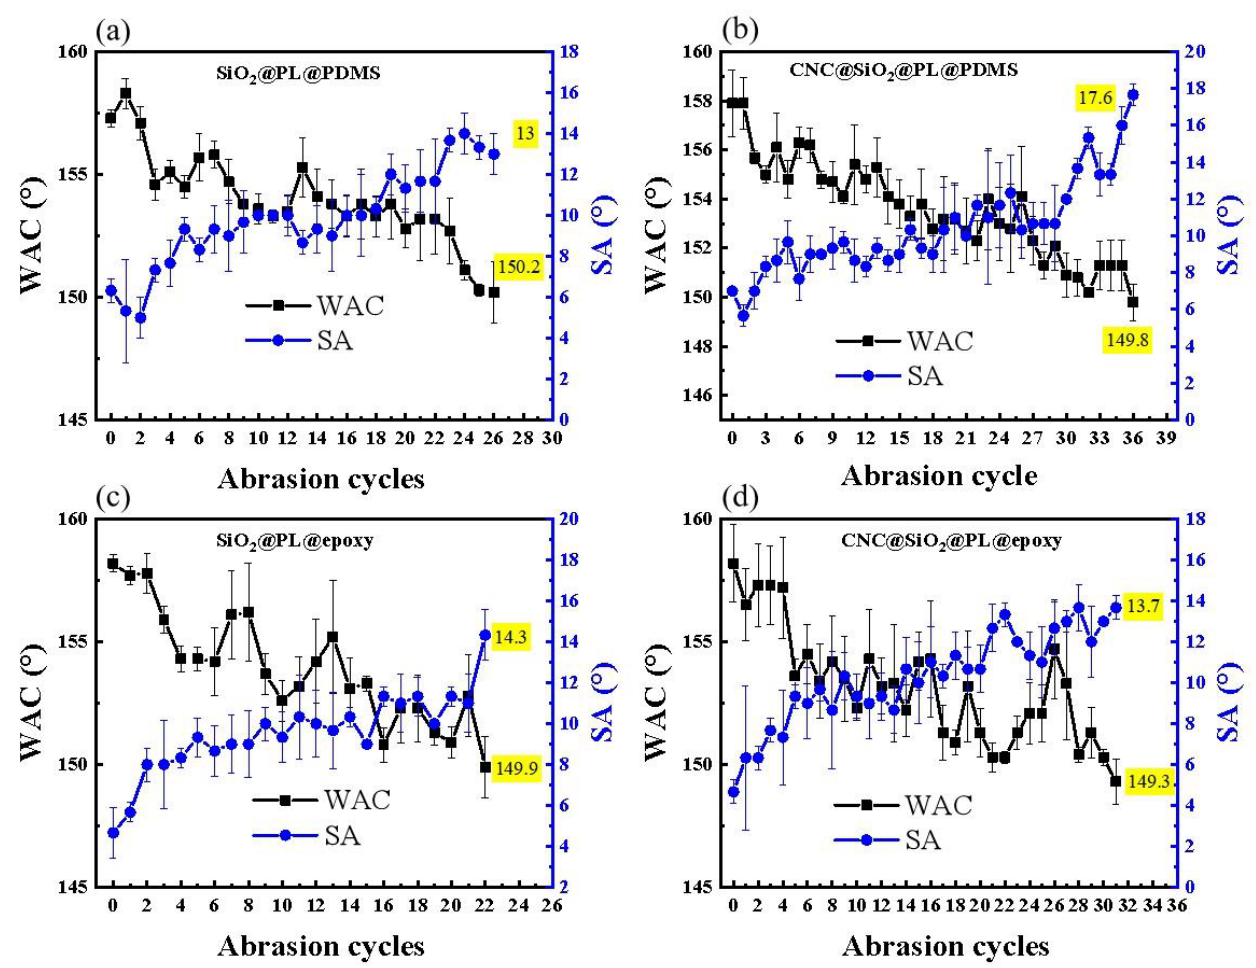
Figure 7. Change curves of WCAs and SAs on the modified ( a ) SiO 2 @PL@PDMS and ( b ) CNC@SiO 2 @PL@PDMS coatings, ( c ) SiO 2 @PL@epoxy and ( d ) CNC@SiO 2 @PL@epoxy coatings.